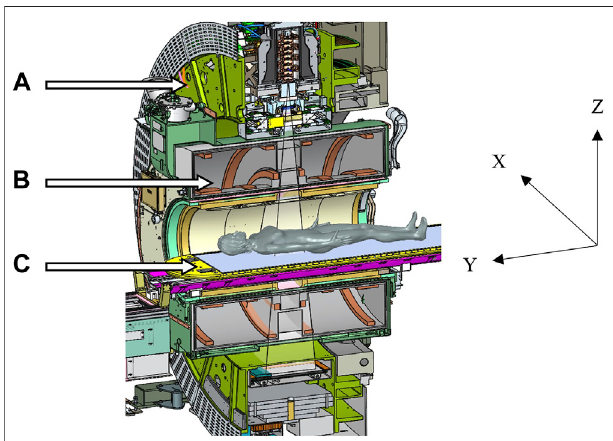
FIGURE 1 | Schematic of the Elekta Unity MR-Linac, courtesy of Elekta, showing (A) thegantryring, (B) thecoilsystemembeddedinthecryostat,and (C) the patient treatment couch. The IEC61217 coordinate system is shown, and the B 0 fi eld is in the – Y direction.